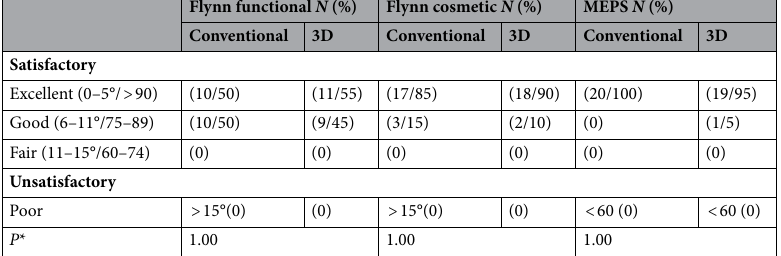
Flynn functional N